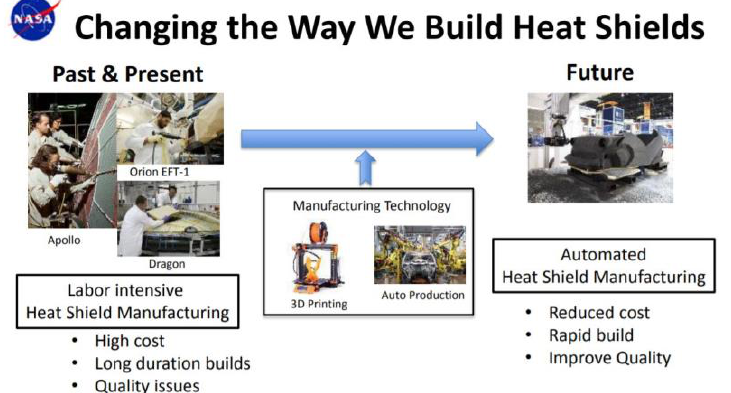
Figure 2. Thermal automation of manufacturing process of thermal protection systems with AM [18]. Credit: NASA.